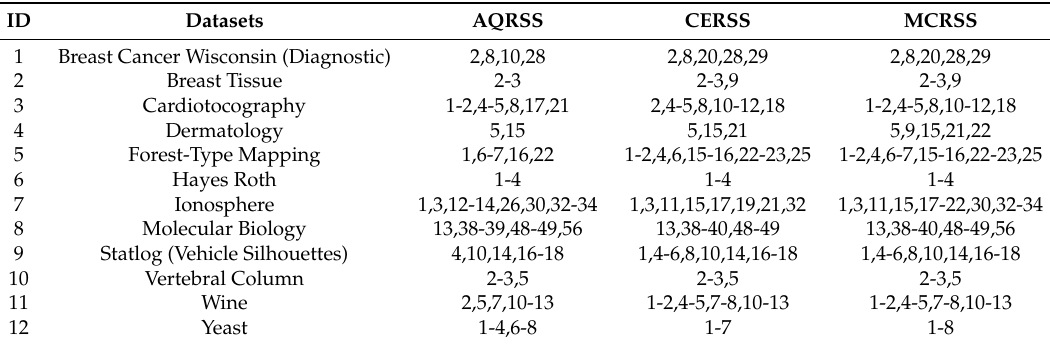
Table 3. Core attributes.